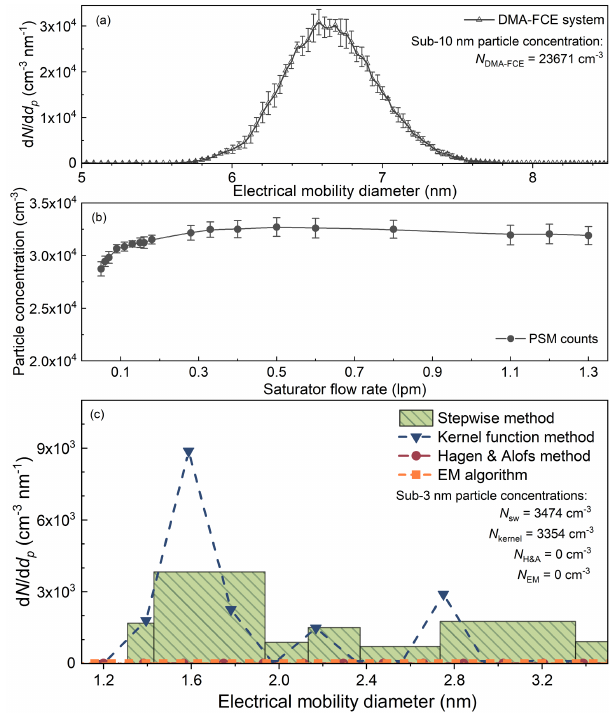
Figure 6. The experimental testing results of the four inversion methods when the PSM was measuring particles larger than 3nm. (a) The particle size distribution detected by the reference half-mini DMA–FCE system. (b) The particle concentrations recorded by the PSM. The error bars indicate the standard deviations of the recorded particle concentrations. (c) The recovered particle distributions us- ing different inversion